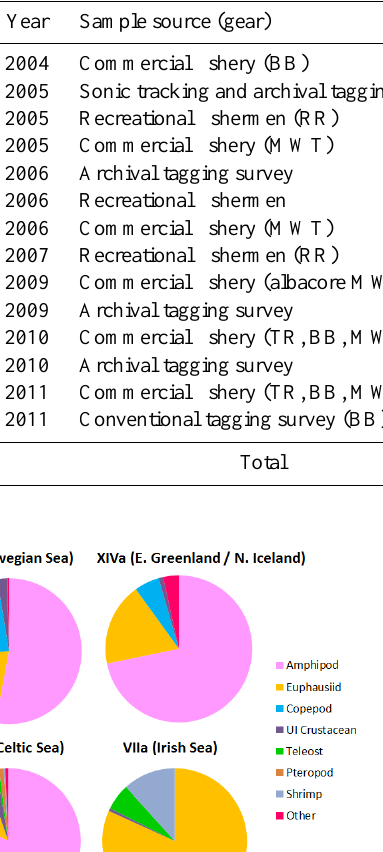
Table 3. Number of stomach content records for albacore and bluefin tuna, sampled in the Bay of Biscay and submitted to the AZTI tuna stomach database as part of EURO-BASIN, by year and fishing gear.